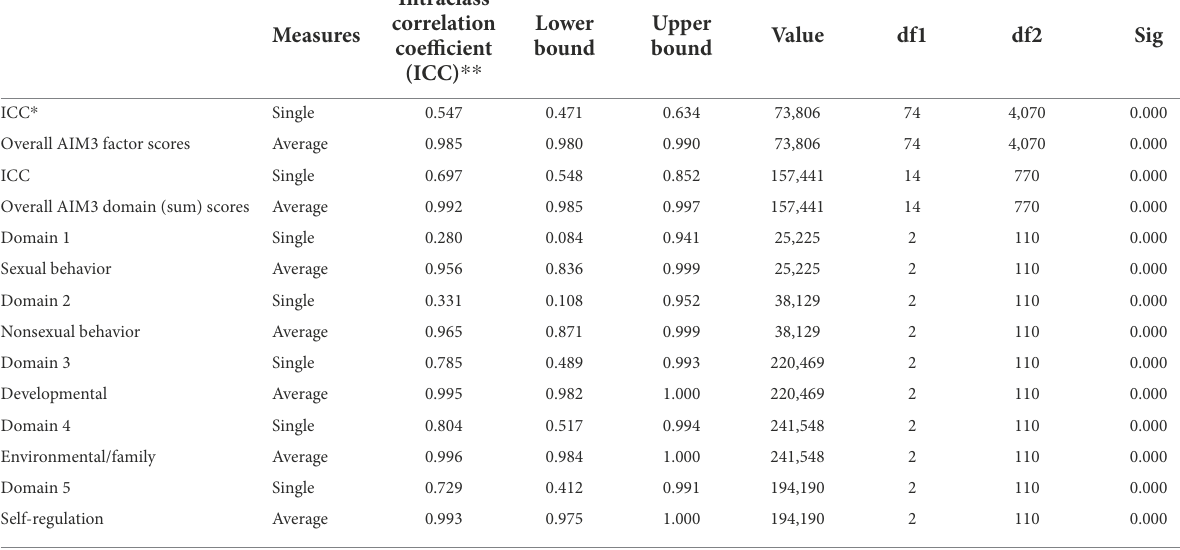
TABLE 2 ICC analysis—AIM3 factor and summarized domain scores.